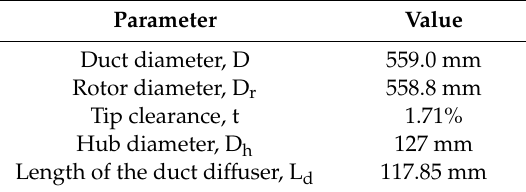
Figure 1. Schematic of counter-rotating ducted fan. Table 1. Counter-rotating ducted fan dimensions.